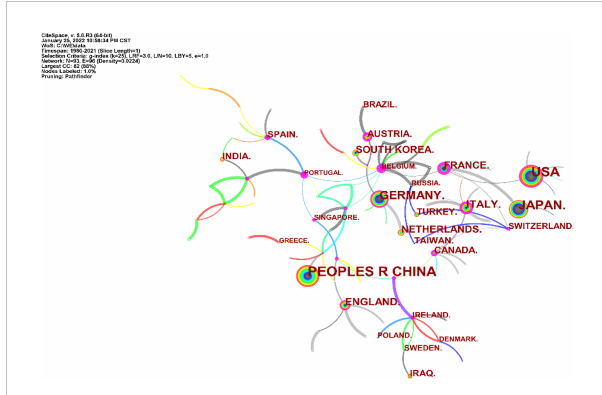
FIGURE 3 Distribution of literature sources related to neoadjuvant chemotherapy for GC from 1991 to 2021 based on